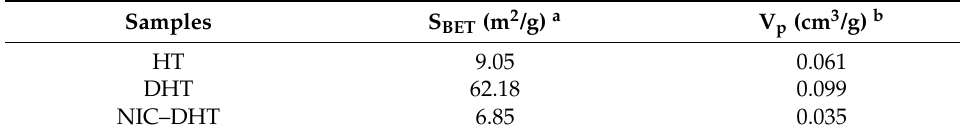
Table 1. Results of N2 adsorption–desorption